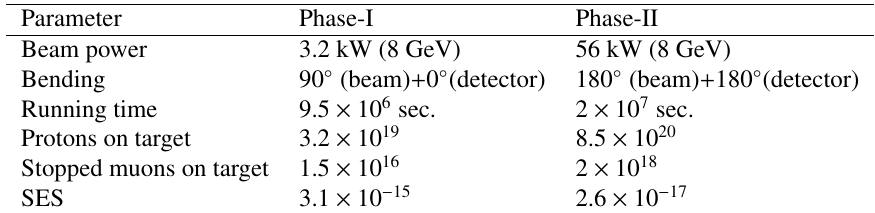
Table 1. Summary of the Phase-I and